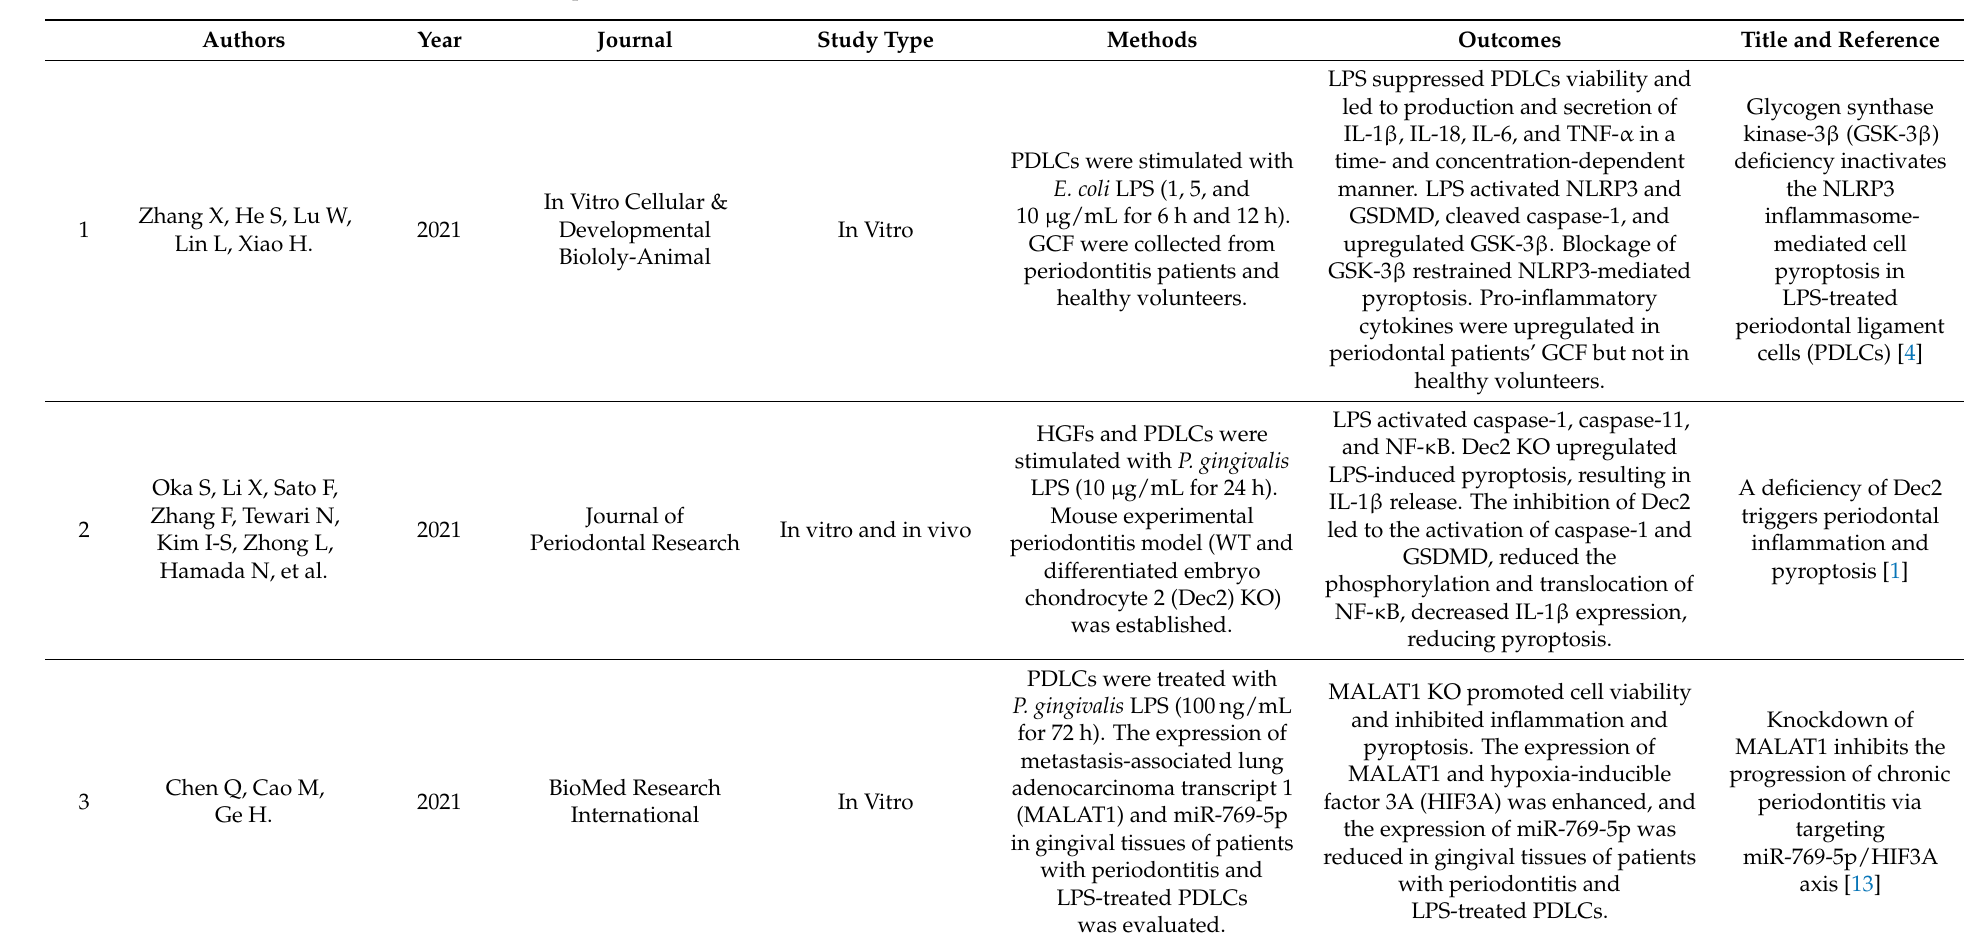
Table 1. Included experimental